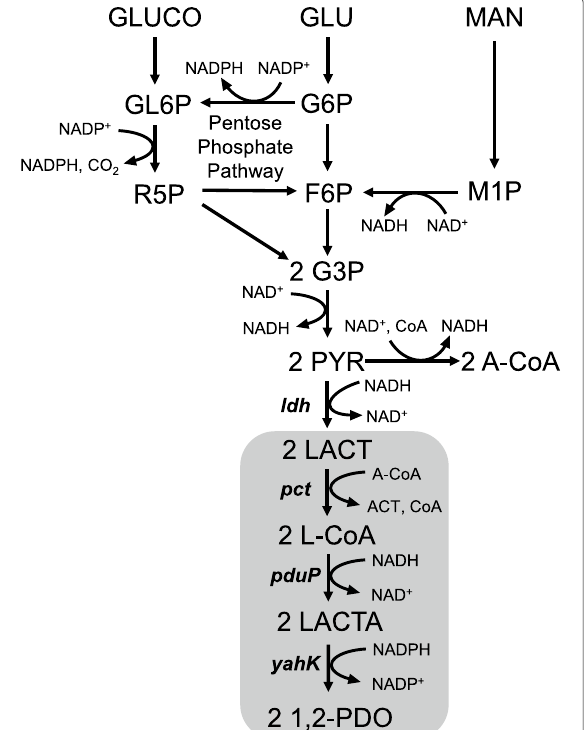
Fig. 1 Metabolic pathway of 1,2-PDO production in engineered L. lactis . 1,2-PDO, 1,2-propanediol; G6P, glucose 6-phosphate; F6P, fructose-6-phosphate; G3P, glyceraldehyde-3-phosphate; M1P, mannitol-1-phosphate; GL6P, gluconate-6-phosphate; R5P, ribose-5-phosphate; PYR, pyruvate; A-CoA, acetyl-coenzyme A; ACT, acetate; GLU, glucose, GLUCO, gluconate; MAN, mannitol; LACT, lactate; L-CoA, lactoyl-CoA; LACTA, lactaldehyde. Italicized letters indicate genes: ldh , lactate dehydrogenase gene; pct , propionate CoA-transferase gene; pduP , aldehyde dehydrogenase gene; yahK , alcohol dehydrogenase gene. The introduced pathway for 1,2-PDO production is colored in